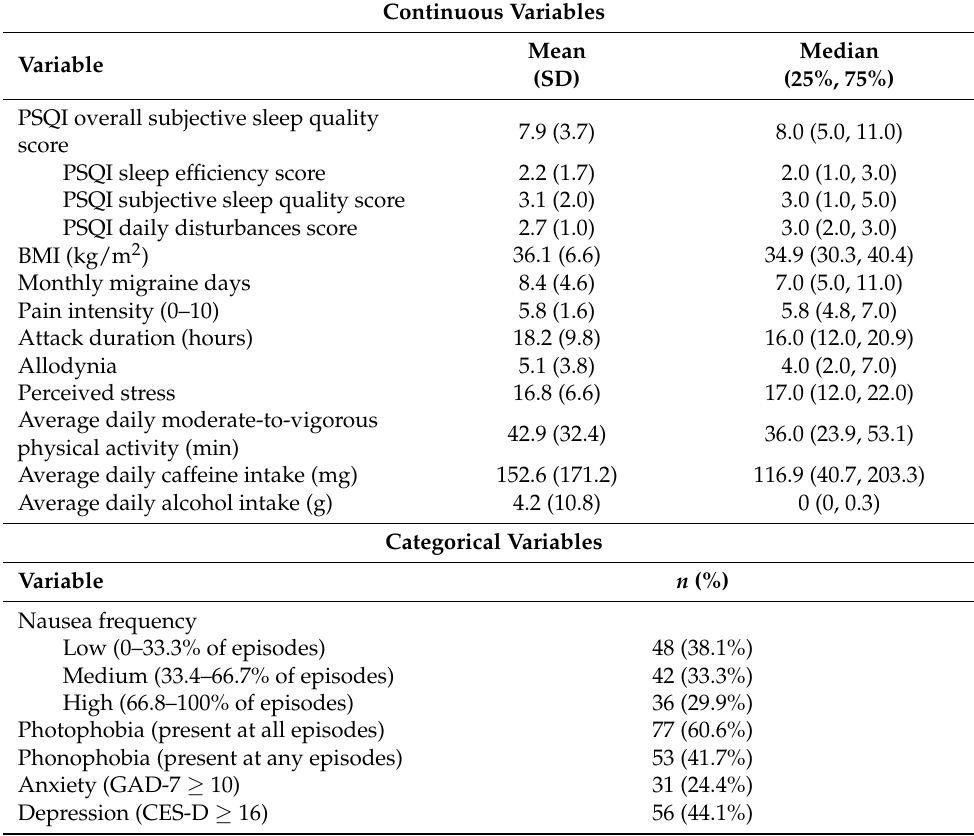
Table 2. Descriptive characteristics for variables of interest for full sample.